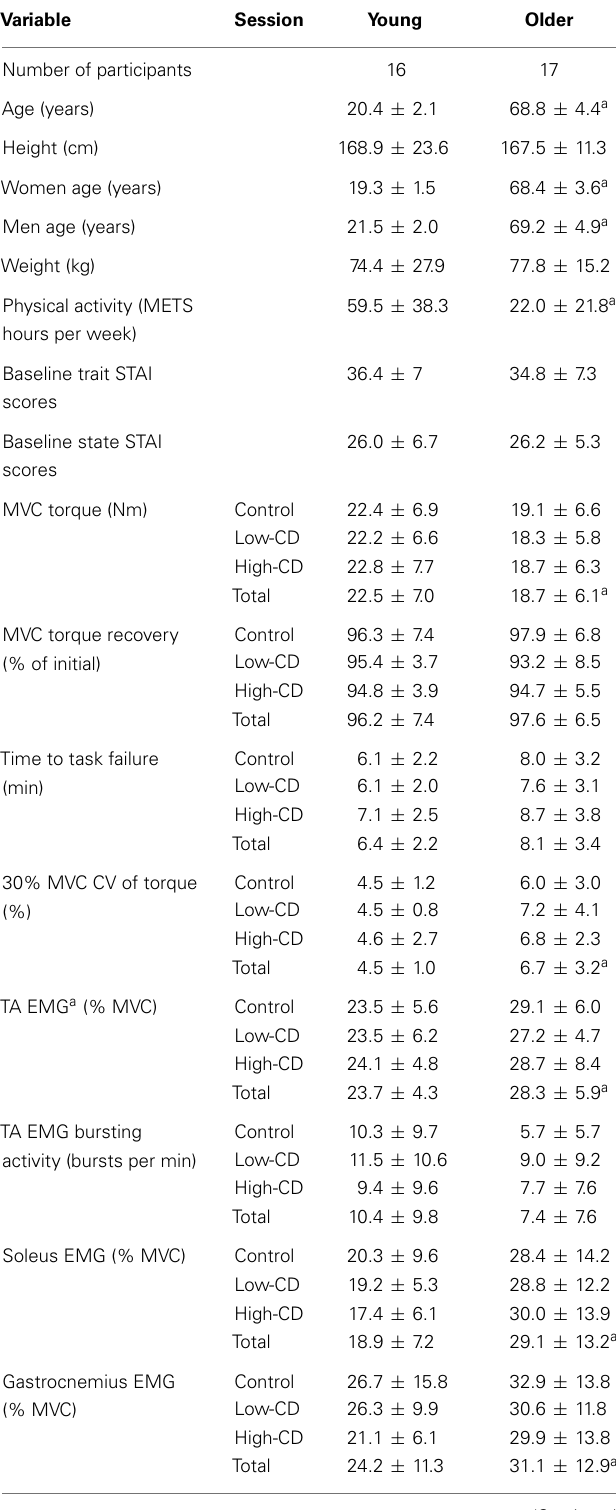
Table 1 | Demographic and physical characteristics and age group means ( ± SD) for control, low-cognitive demand (low-CD), and high-cognitive demand (high-CD) sessions